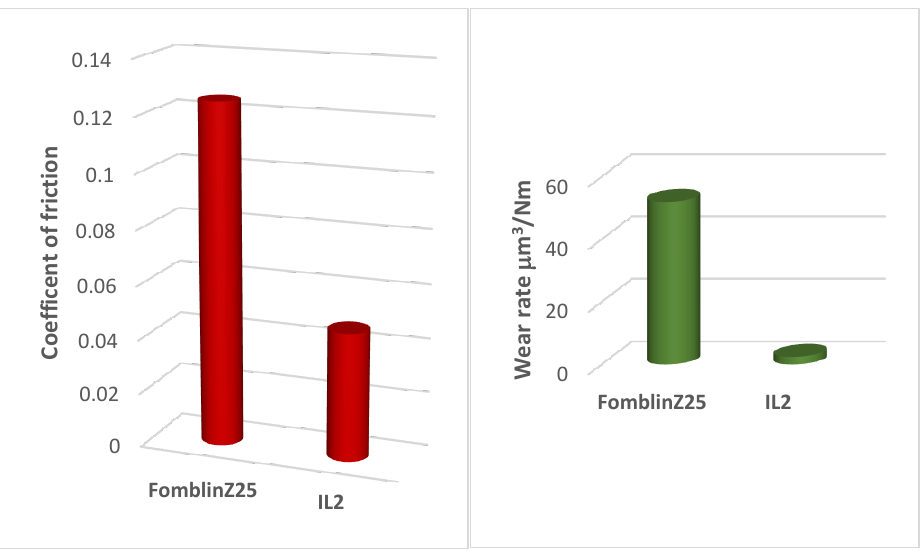
Figure 11. Coefficient of friction and wear rate of Fomblin Z25 compared to IL2.